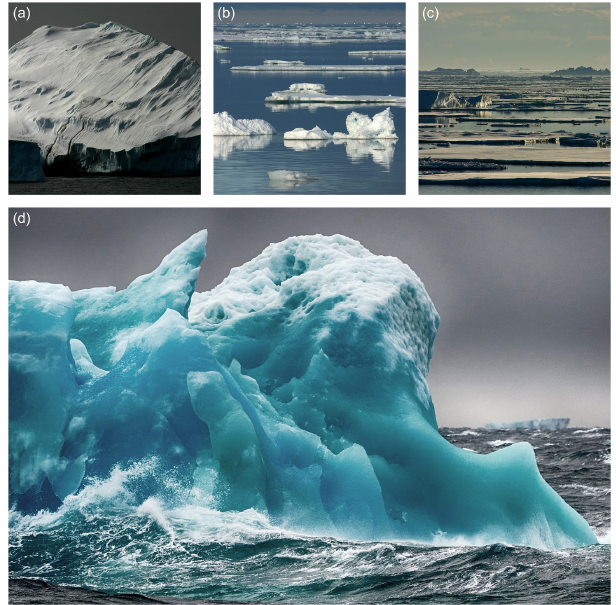
Figure 5. Icebergs and ice tongues in Antarctica. (a) Collapsed iceberg in the Ross Sea during the XXIX PNRA expedition under the ROSSLOPE II project. (b) Iceberg wall in the Ross Sea dur- ing the XXI PNRA Antarctic expedition under the WISE project. (c) Floating blue iceberg in the Ross Sea during the XXVIII PNRA expedition under the ROSSLOPE II project. (d) Drygalski glacier tongue in the Ross Sea during the XXXI PNRA expedition un- der the Holocene climatic fluctuations in sub-millennial recorded in sedimentary sequences expanded the Ross Sea (HOLOFERNE)